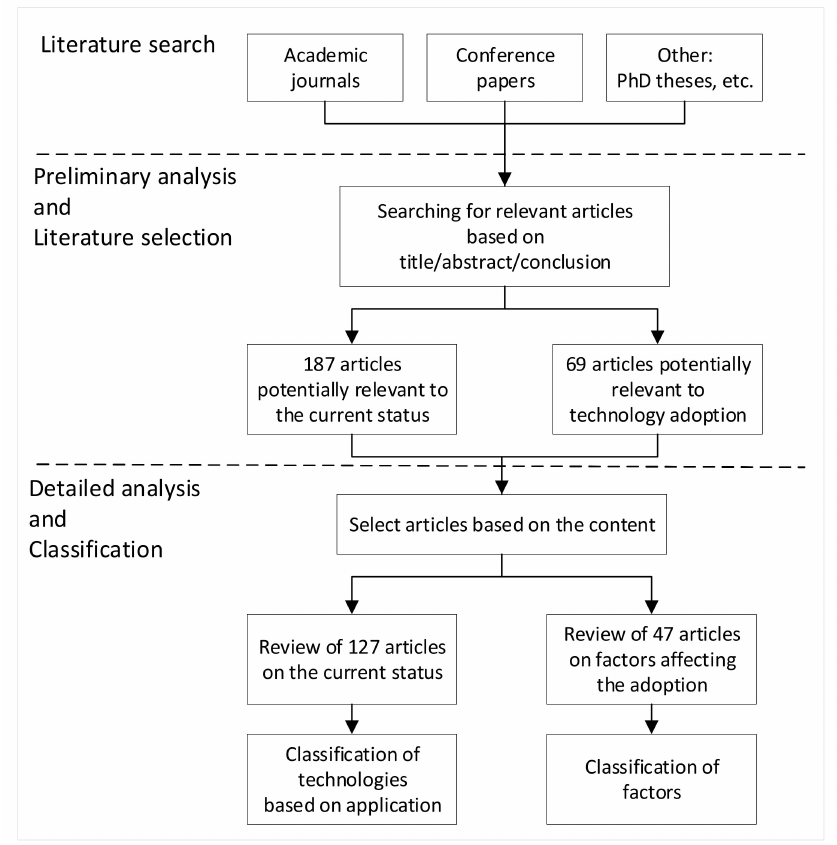
Figure 1. Method for literature